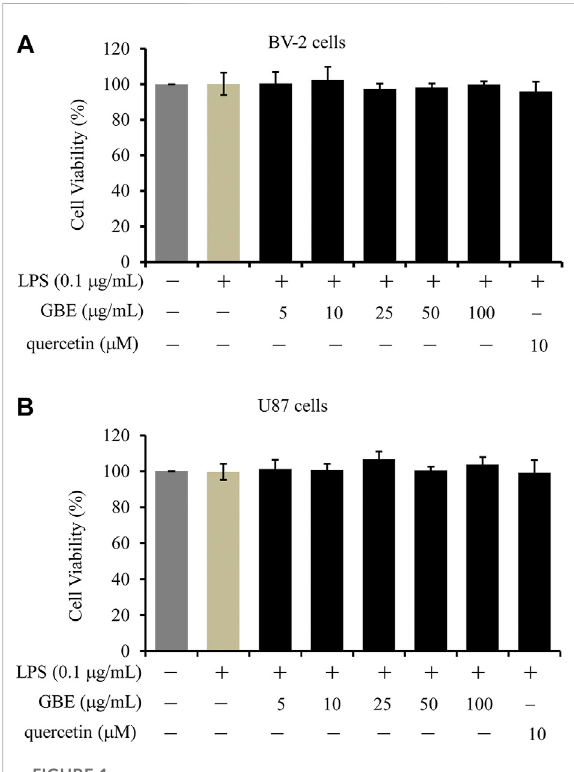
FIGURE 1 TheeffectsofGBEontheviabilityofBV-2microglialcellsand U87 cells. BV-2 microglial cells (A) and U87 cells (B) were treated with GBE (5 – 100 µg/ml) or quercetin (10 µM) for 25 h with